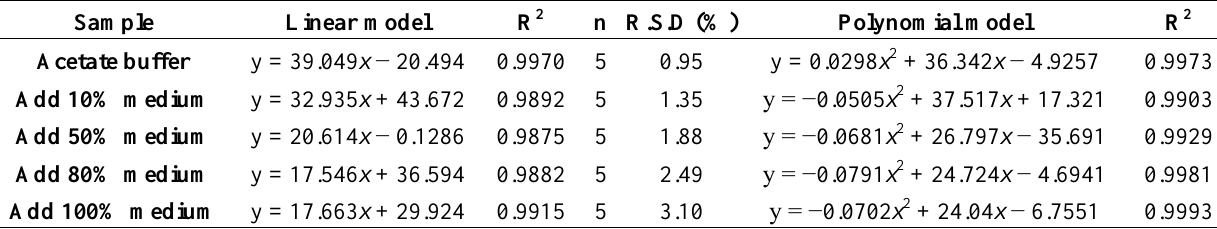
Table 2. The effect of cultivation medium additions into supporting electrolyte on cadmium(II) ions peak